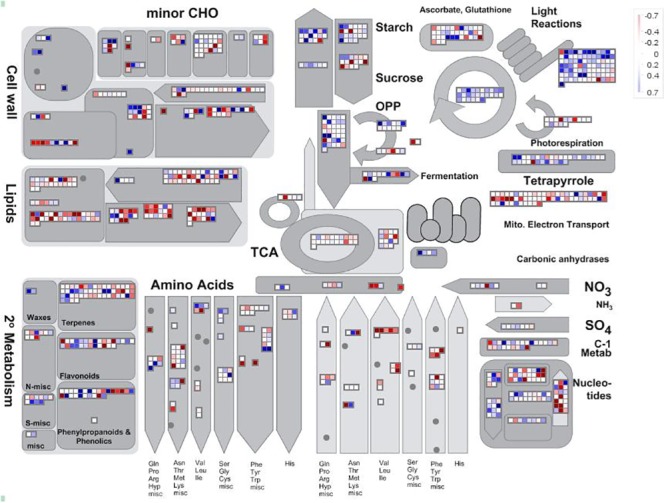
Pathway analysis of genes expressed in the E. sideroxylon mosaic.Blue squares indicate transcripts with higher levels of abundant in the leaves of the susceptible branch and red squares indicate transcripts more abundant in the leaves of the resistant branch. THE intensity of the colour indicates the level of differential abundance of a transcript.